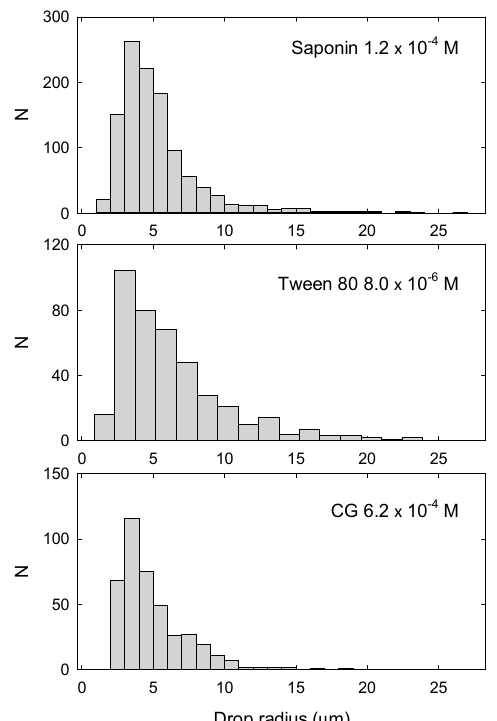
12 of 20 Figure 9. Typical microscope image of an emulsion stabilized by CG at 6.2 × 10 − 4 M, where the composite feature of the disperse phase is evident. The emulsions were also analyzed by optical microscopy at the beginning of their evolution, when they are completely emulsified. Figure 10 shows some examples of size distribution obtained